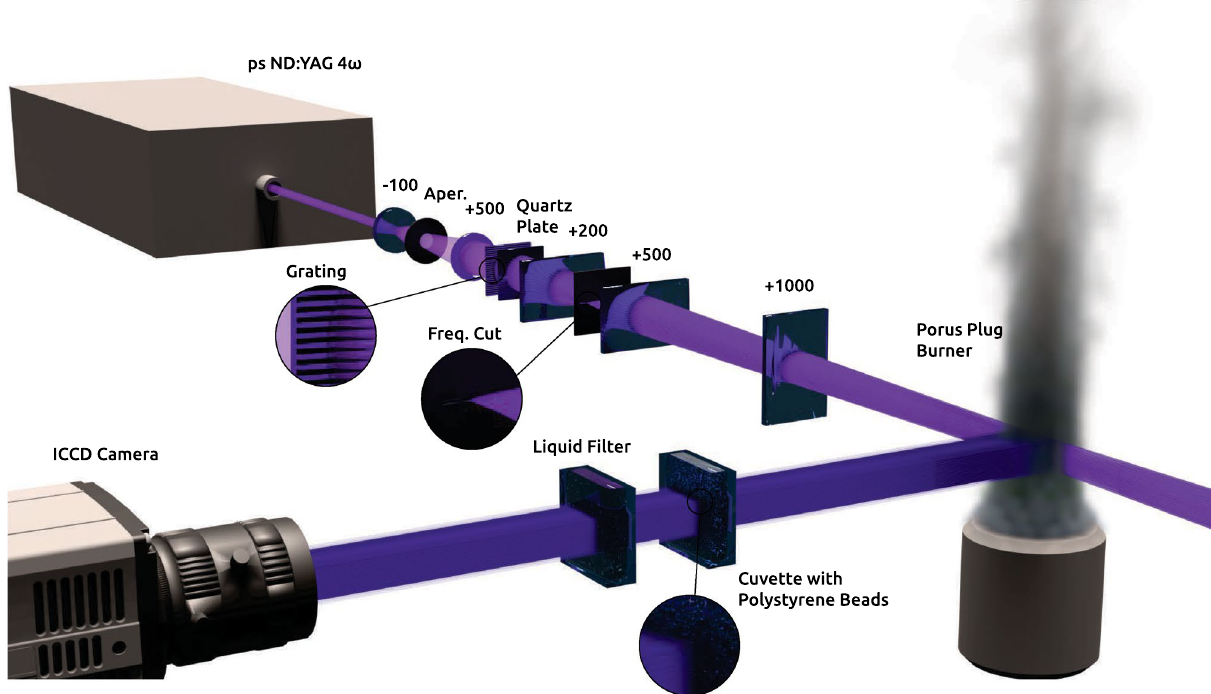
Figure 4. Schematic image of the experimental setup, all units are in mm. A water-filled quartz cuvette is located between the gaseous flow and the ICCD camera. The cuvette was seeded with polystyrene spheres to introduce scattering in the imaging